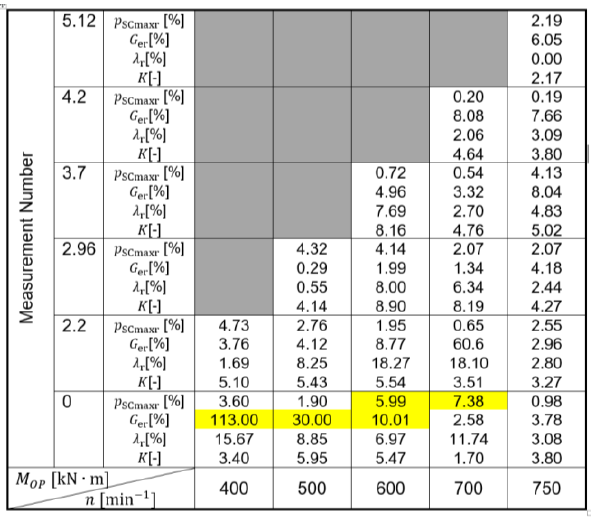
Table 1. The adequacy measure rates adopted for the engine of full tech- nical state